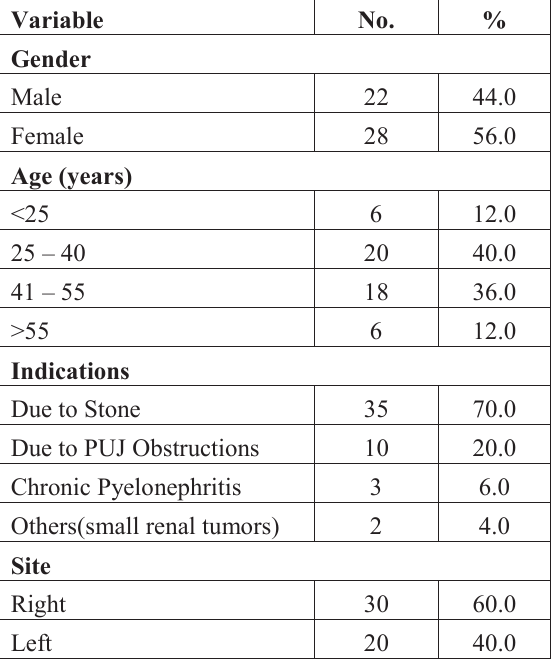
Table-1: Demographic information of the patients